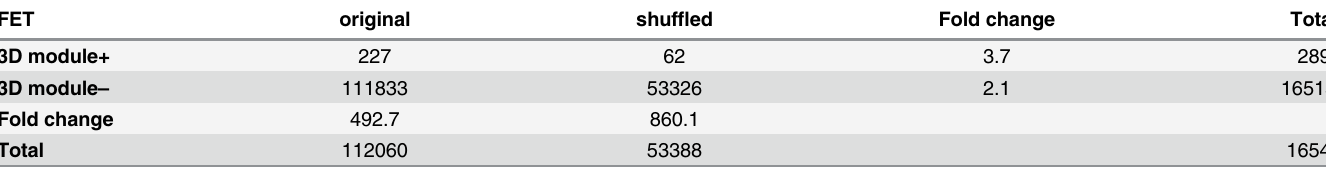
Table 1. Contingency table for mRm IL model RF00177_235_2HHH_1380_1383_1471_1475 showing the number of original (second column) and shuffled windows (third column) with the ( “ 3D module+ ” ) and without the module ( “ 3D module –” ). Furthermore, the respective fold change (the ratio of 3D module- and 3D module+ windows and the ratio between original and shuffled windows with and without 3D modules) and the sum ( “ Total ” ) of each row and column is shown. The adjusted p-value of the FET equals 9.8 × 10 − 4 with an odds ratio of (227/111 833)/(62/53 326) =